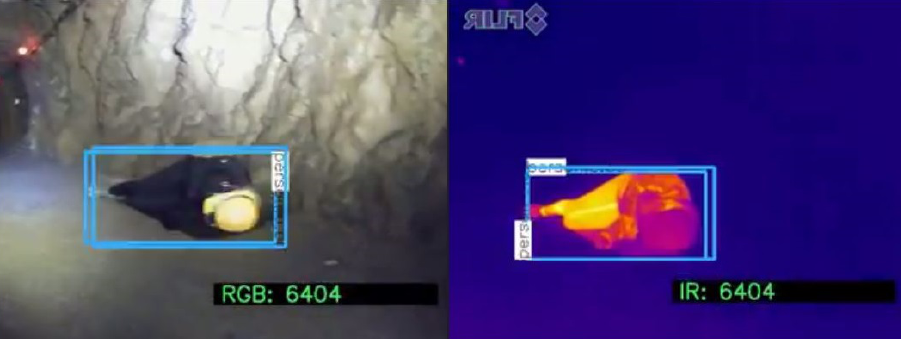
Figure 20. Human lying—correct detection with algorithm